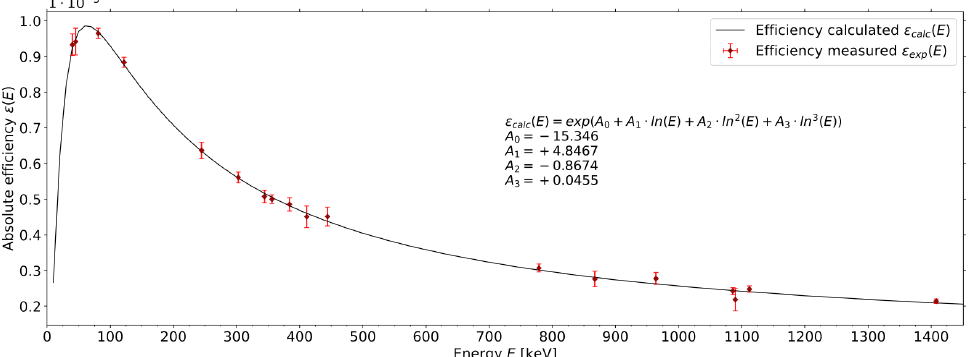
Figure 5. Absolute efficiency for n-type Extended Range Coaxial Ge detector (XtRa), model GX6020 at the distance of 50 cm from the source. Measured efficiency ε exp ( E ) (in red) was plotted based on 152 Eu and 133 Ba measurements. A polynomial of 3rd degree ε calc ( E ) (in black) was fitted to the experimental data. The equation and fit parameters are enclosed in